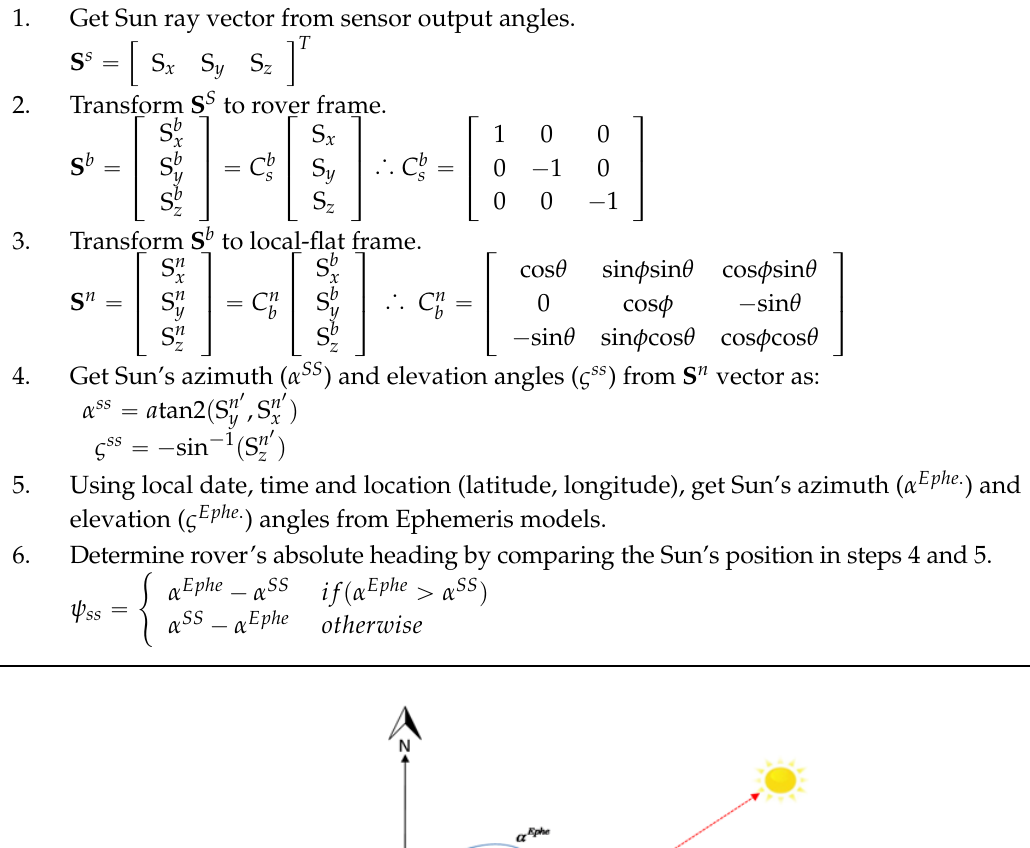
Algorithm 1. Estimation of Absolute heading angle using Sun sensor and Inclinometer ( EASI algorithm) 1.